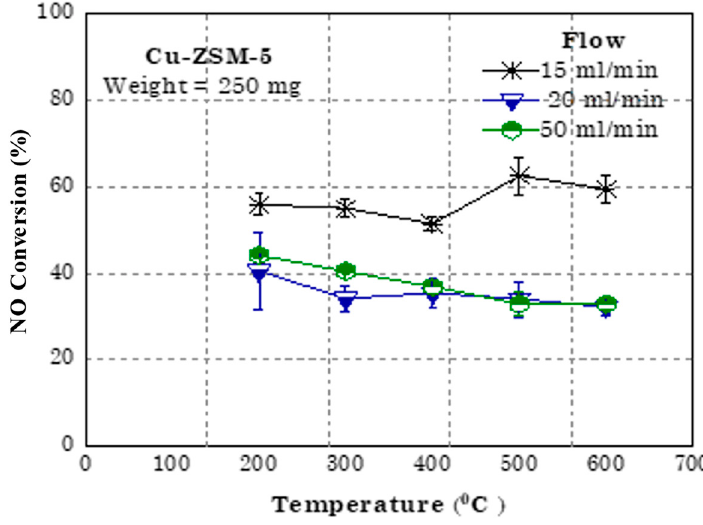
Figure 13. NO conversion rate (%) vs. temperature (°C) for Cu-ZSM5.